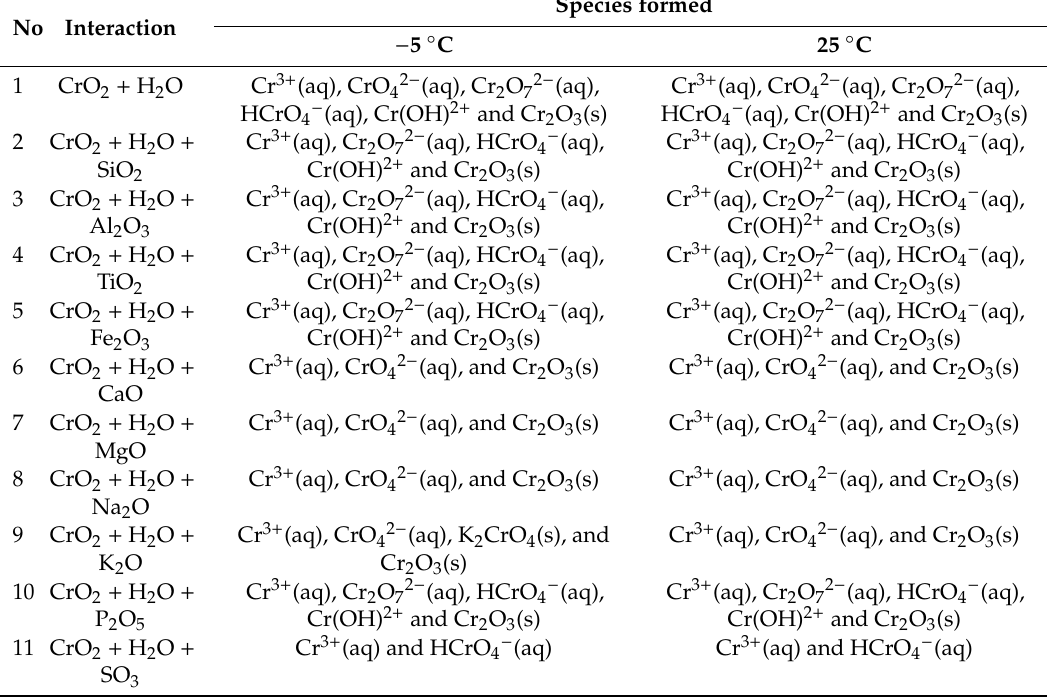
Table 5. Interaction of predicted chromium (CrO 2 ) with mineral components during leaching process.